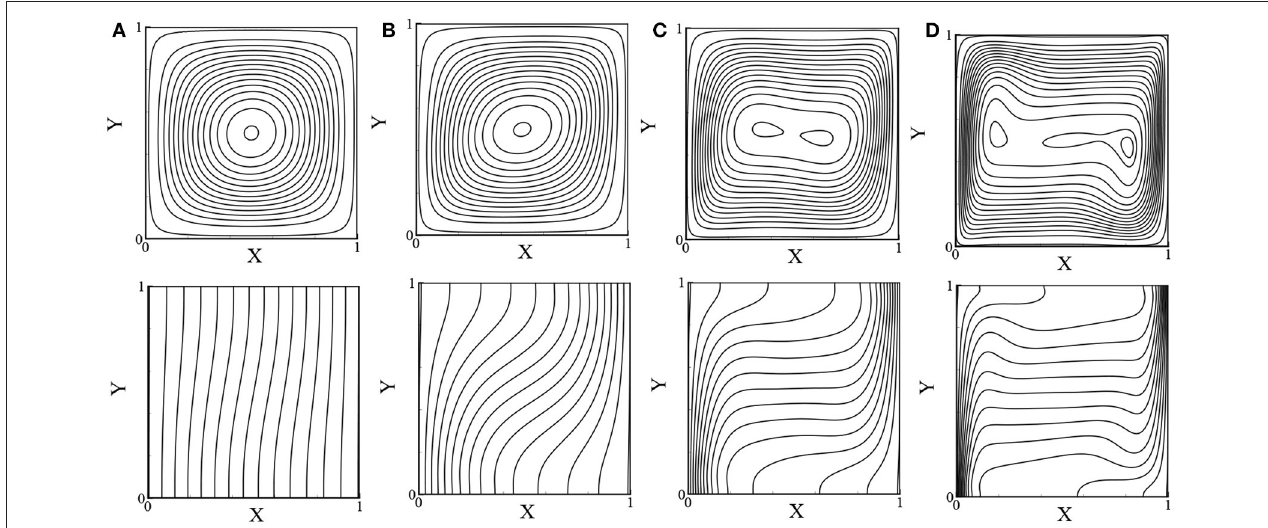
FIGURE 8 | Streamlines (top) and isotherms (bottom): (A) Ra